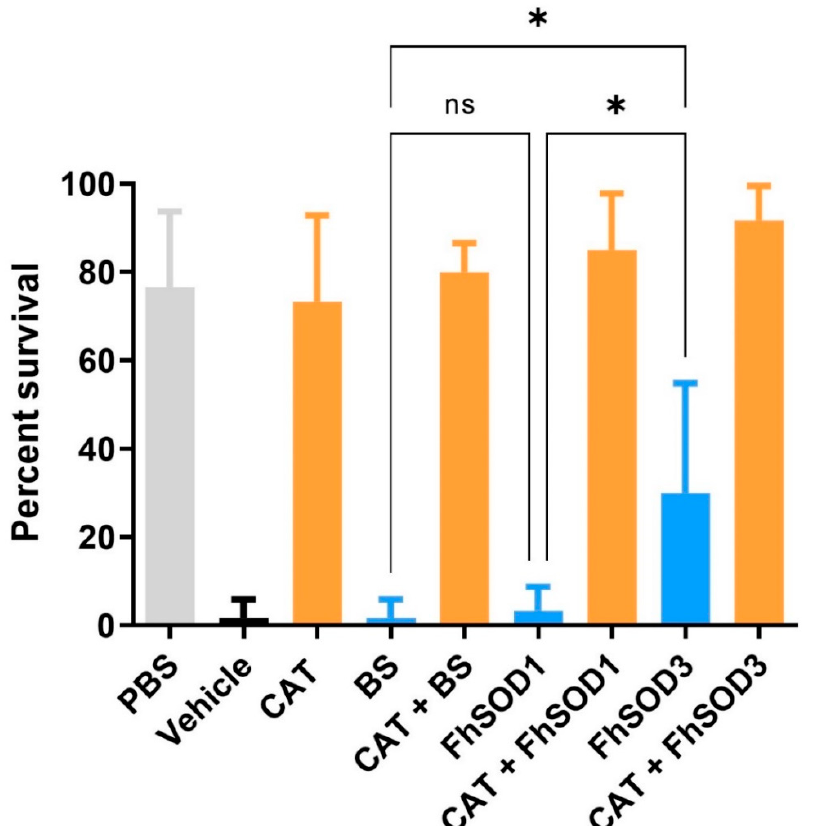
Figure 8. Susceptibility of F. hepatica NEJ to superoxide and their subsequent protection via the addition of SOD and catalase. Six replicates of 10 NEJ/well were incubated in the presence of enzymatically generated superoxide for 24 h at 37 ◦ C and 5% CO 2 . PBS; phosphate buffered saline (negative control), Vehicle; assay buffer containing enzymatically generated superoxide via the step-wise reduction of hypoxanthine into xanthine and superoxide by xanthine oxidase (positive control), CAT; recombinant catalase, BS; native bovine erythrocyte SOD, ns; not significant (0.1234), * p < 0.0332.